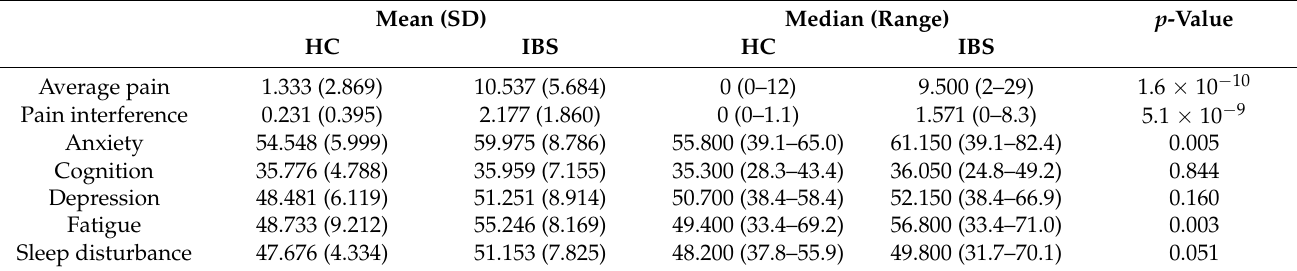
Table 2. Pain and psychological symptom measurements.